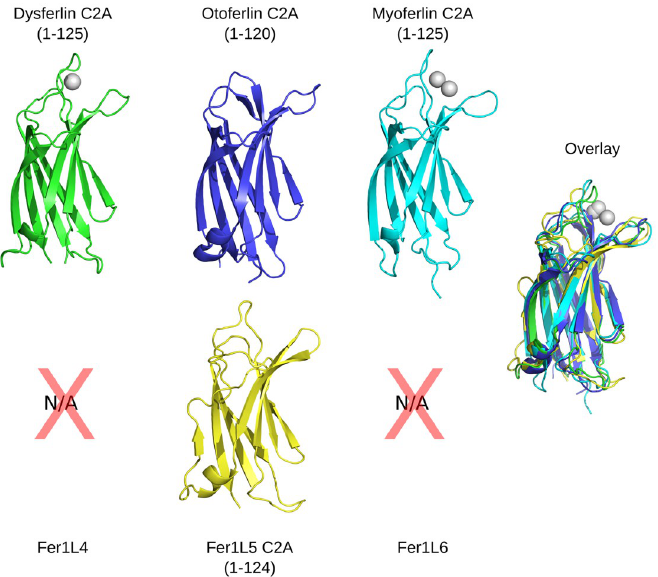
Fig 3. C2A structures and model of C2A from Fer1L5. Dysferlin C2A (green, 4IHB), otoferlin C2A (blue, 3L9B), myoferlin C2A (cyan, 6EEL), and Fer1L5 C2A (yellow). The gray spheres are the divalent cations from the crystal structures of dysferlin C2A (4IHB, chain E) and myoferlin C2A (6EEL). The amino acid boundaries from each respective C2 domain are listed with the domain assignment. The superposition of all four C2A domains is labeled as ‘Overlay’. The ferlins without a C2A domain are listed as Not Applicable (N/A).